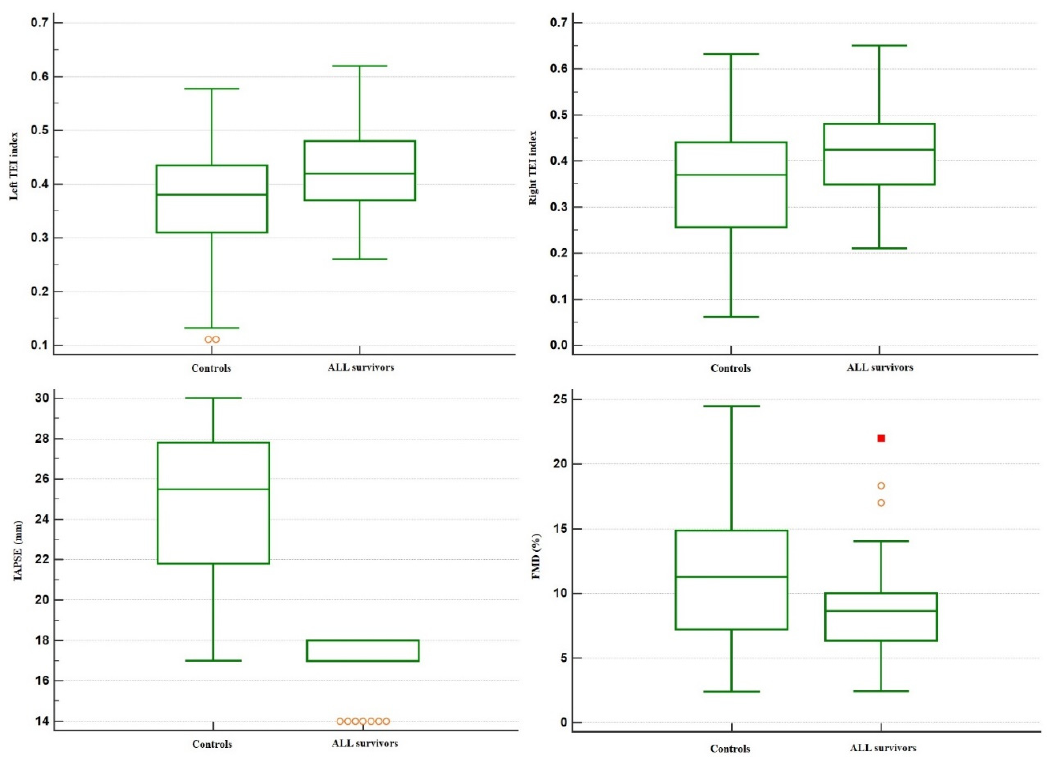
Figure 1. Box plots of left and right TEI index, tricuspid annular plane excursion (TAPSE), and flow-mediated vasodilatation of the brachial artery (FMD) in healthy controls and childhood cancer survivors. The orange circles and red square represent the outliers.